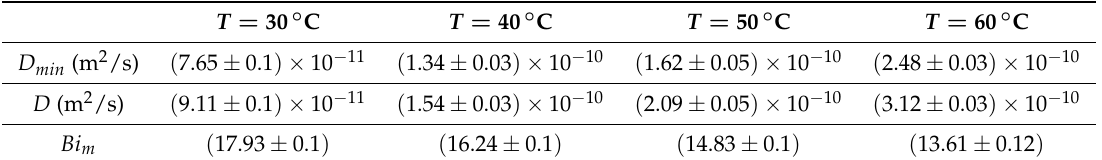
Table 5. Estimated water diffusivities D min , D and Biot number Bi m for cocoa beans of data set (1) for different drying temperatures T and v = 0.6